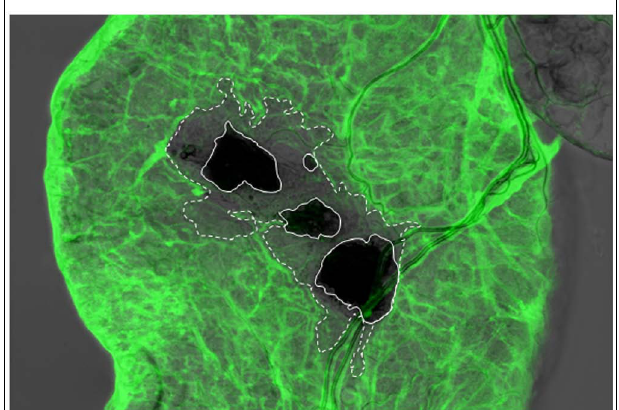
FIGURE 3 | Integrity of the basement membrane (BM) is disrupted around the wound site upon nematode infection of the Drosophila larva. Viking (Collagen IV)-GFP fusion protein (protein trap) was used as a basement membrane reporter to analyze nematode infected Drosophila gut using confocal microscopy. Expression of theViking-GFP is controlled by the endogenous promoter and enhancer elements. Note thatViking-GFP (green) signal was missing beyond the melanized area in the wound site (dark black, straight line, the area that lacks the green signal is outlined by the dashed line), which was caused by the nematode (Arefin etal., 2014; re-produced with kind permission from S. Karger AG,